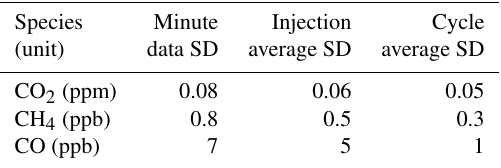
Table 2. ATC MLab typical thresholds for calibration quality con- trol (in standard deviation, SD). The minute data SD takes into con- sideration the SD of each minute of the injection. The injection av- erage SD takes into consideration the SD of all the minutes of one injection, and the cycle average SD takes into consideration the SD of the two to three